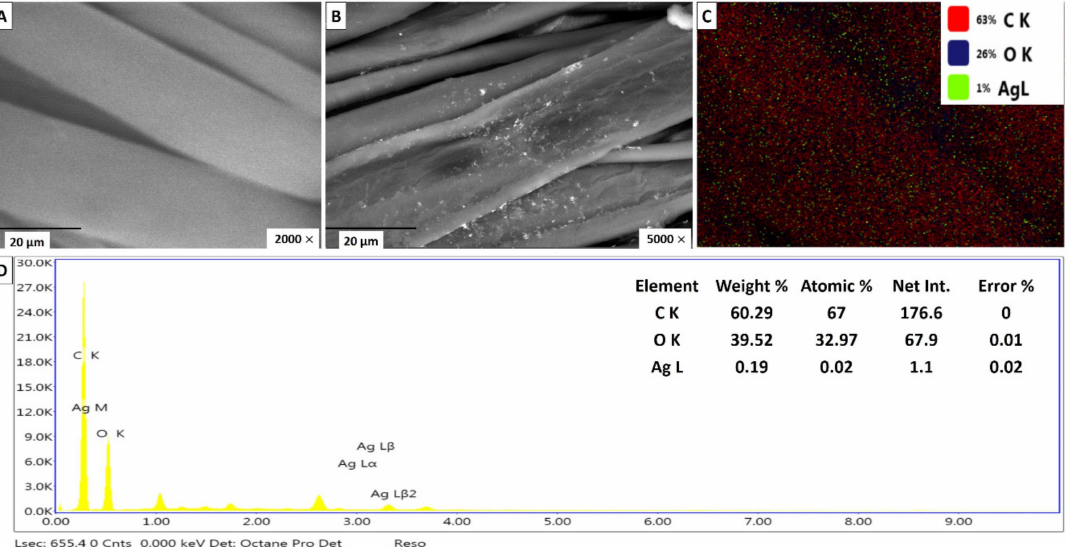
Figure 7. Scanning electron microscope (SEM) image ( A ) Blank cotton fabric; ( B ) treated cotton fabrics with Ag-NPs 100 ppm; ( C ) mapping picture of the surface of treated fabrics with Ag-NPs; and ( D ) energy dispersive X-ray spectroscopy (EDX) of a treated sample with elemental analysis of the Ag-NPs contents.